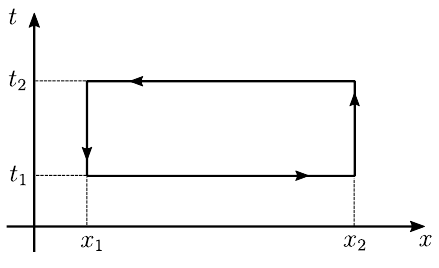
Figure 5: Closed path relative to the definition of the monodromy matrices Eq. (69)